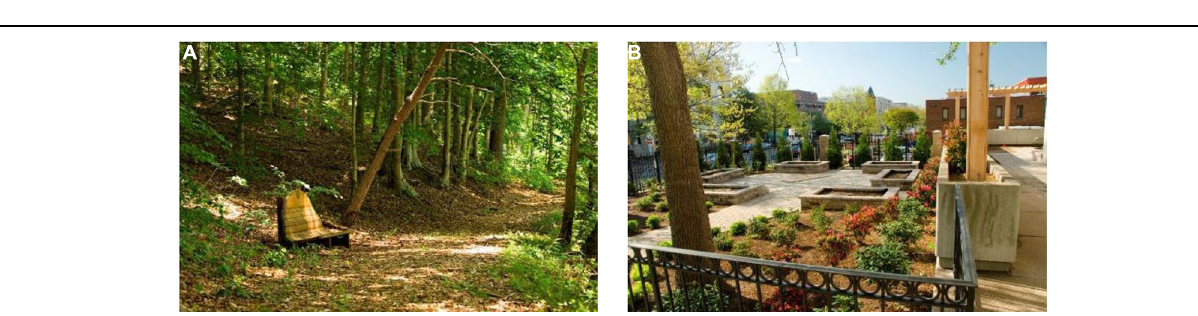
depending on how sharp of an edge it belonged to. This